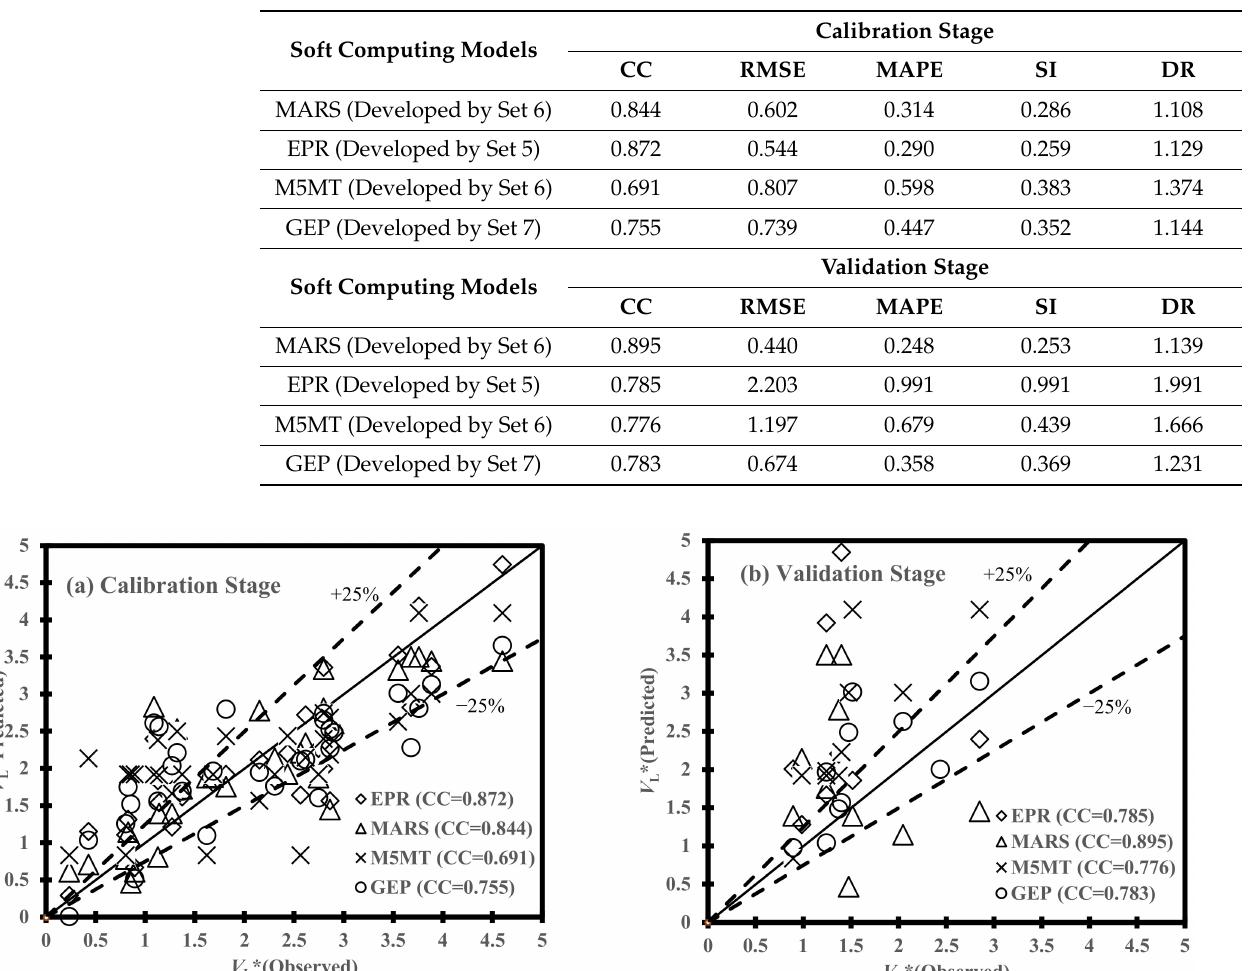
Figure 5. Performance of soft computing models in the prediction of V L * for ( a ) calibration and ( b ) validation